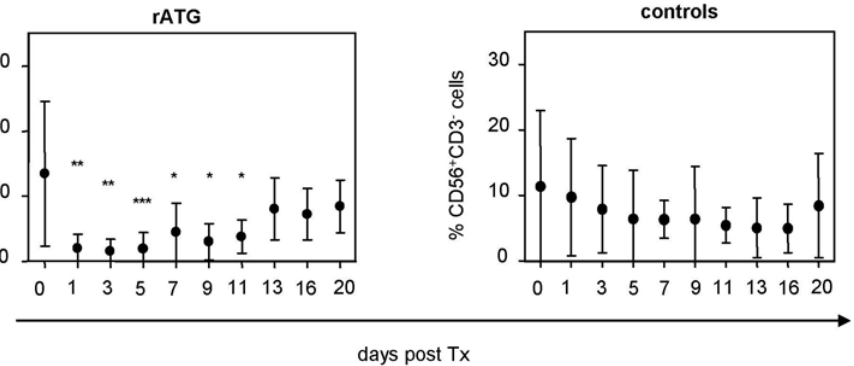
Figure 1. Induction therapy of rATG in simultaneous kidney/pancreas transplantation results in a significant decrease of NK cells. Patients (n=8) initially received 1.5 mg/kg body weight i.v. rATG (Thymoglobulin, Genzyme GmbH, Neu Isenburg, Germany) starting at day 0 followed by 4 further consecutive days posttransplantation in combination with tacrolimus, mycophenolate mofetil and steroids. We further enrolled nine patients who received a renal allograft as a control group. Control patients received two dosages of basiliximab (20 mg i.v., day 0 and day 4). Asterisks denote significant differences compared to pretransplant levels of CD3 2 CD56 + NK cells.